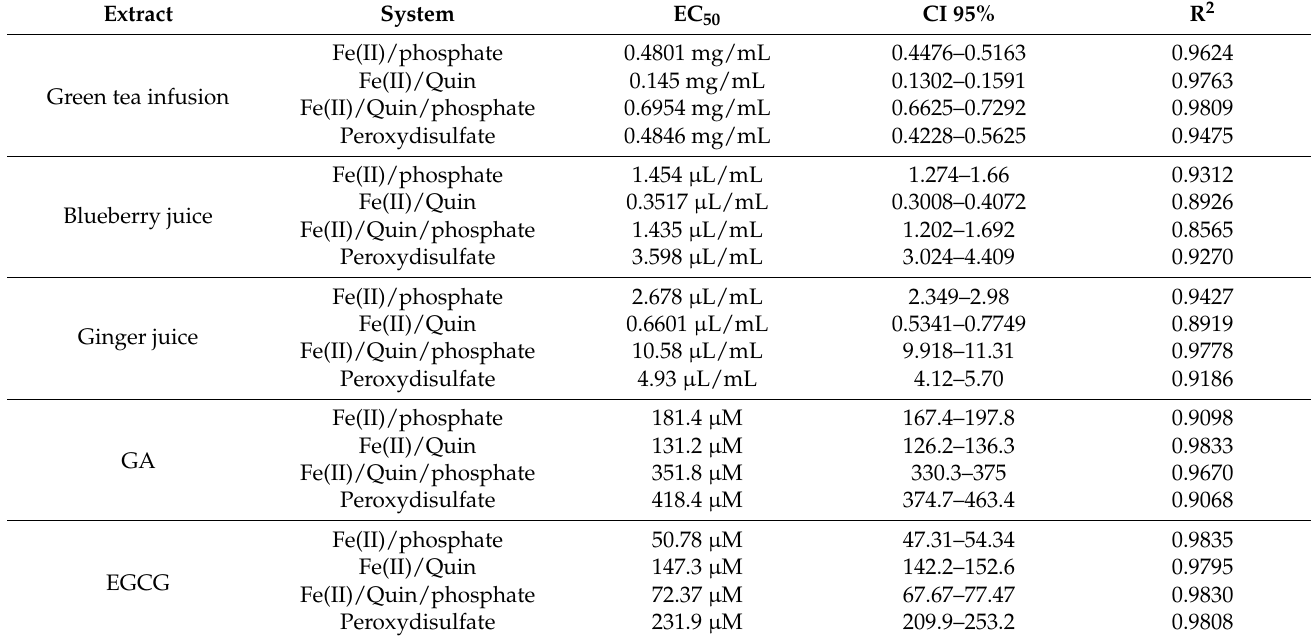
Table 1. EC 50 and the corresponding CI 95% values obtained from the graphs % of inhibition vs. log (conc.) with nonlinear fit—straight